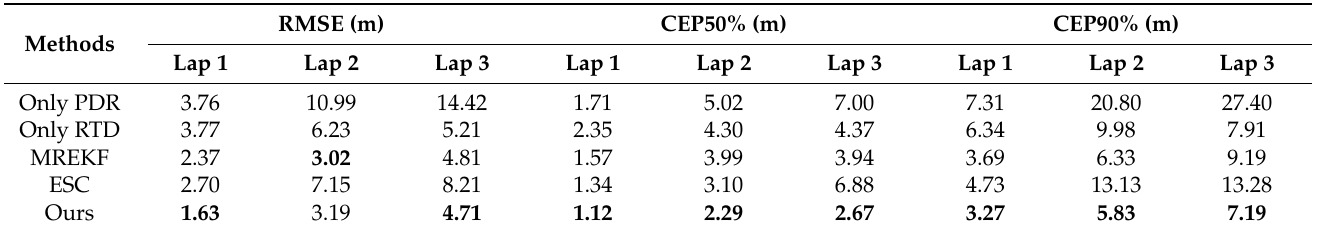
Table 2. Comparison of three-lap GNSS/PDR fusion test of five pedestrian positioning